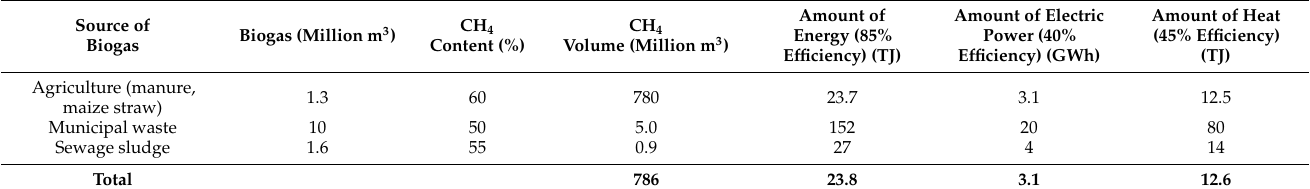
Table 2. Electric power and heat production from biogas in the Greater Poland Voivodeship (own